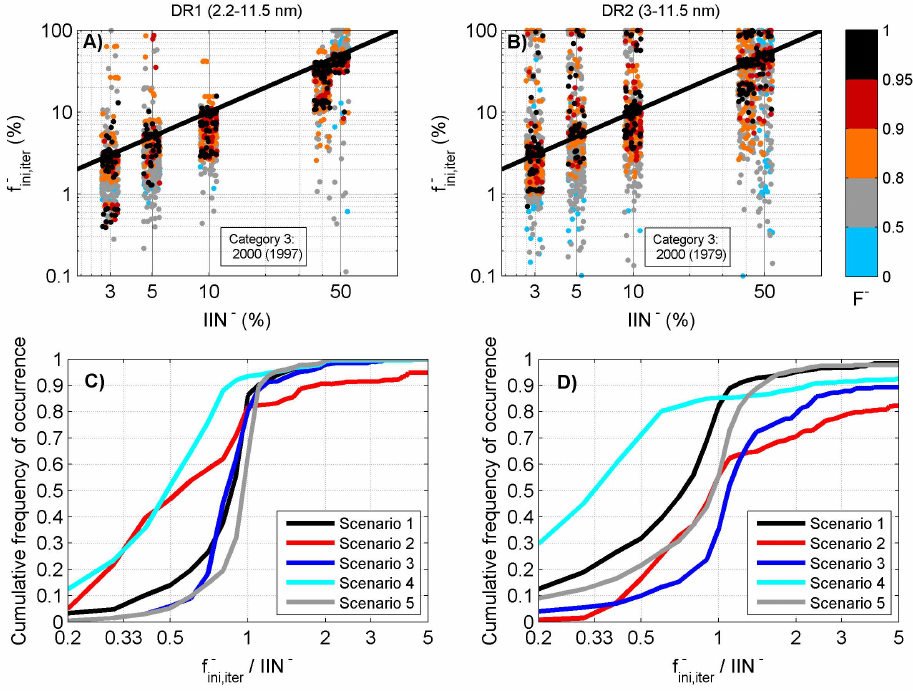
Fig. A1. The initial negative charged fractions determined with the iteration method using asymmetric small ion concentrations as a function of the proportion of IIN − used as input in the model are depicted in the upper panels. The colour denotes the fraction of the change rate of the negative charged fraction that was taken into account in the method (see details in Appendix B). The solid black line denotes the one to one correspondence. The numbers denote the number of data points in category 3 with the numbers in parenthesis denoting the number of < 0.1%. The cumulative frequency of occurrence data points shown in the figure. The points not shown in the figure had the value of f − ini,iter of the ratio of the determined charged fraction and the fraction of IIN − are depicted in the lower panels with different colours denoting different GR scenarios used in the simulations. All of the data points in category 3 were used to obtain the curves in (C) and (D) . The panels on the left ( A and C ) and right hand side ( B and D ) denote the results obtained using data from DR 1 (2.2–11.5nm) and DR 2 (3–11.5nm), respectively. A random variation of up to 10% is added to the values on the x-axis of (A) and (B) to make data points more